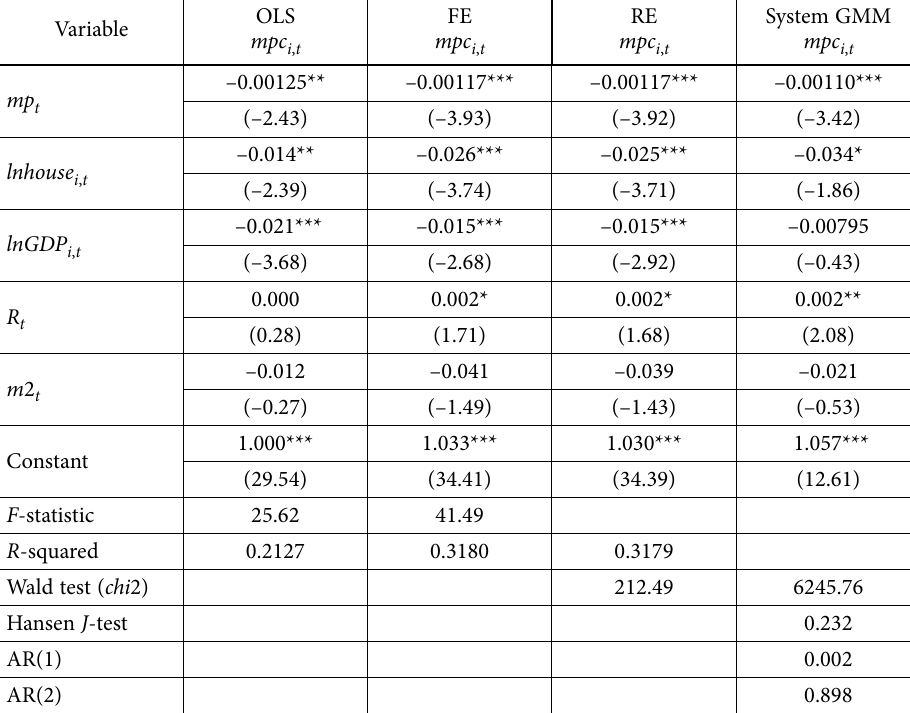
Table 7. The impact of macroprudential policies on the real estate